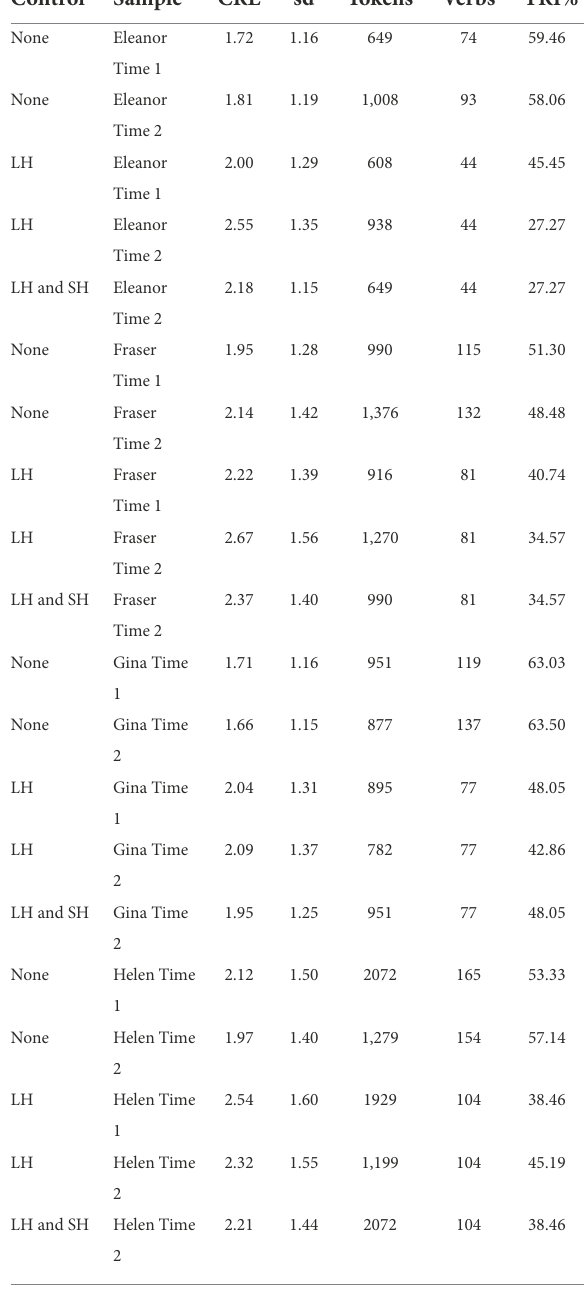
TABLE 6 Developmental results for the English speaking children.